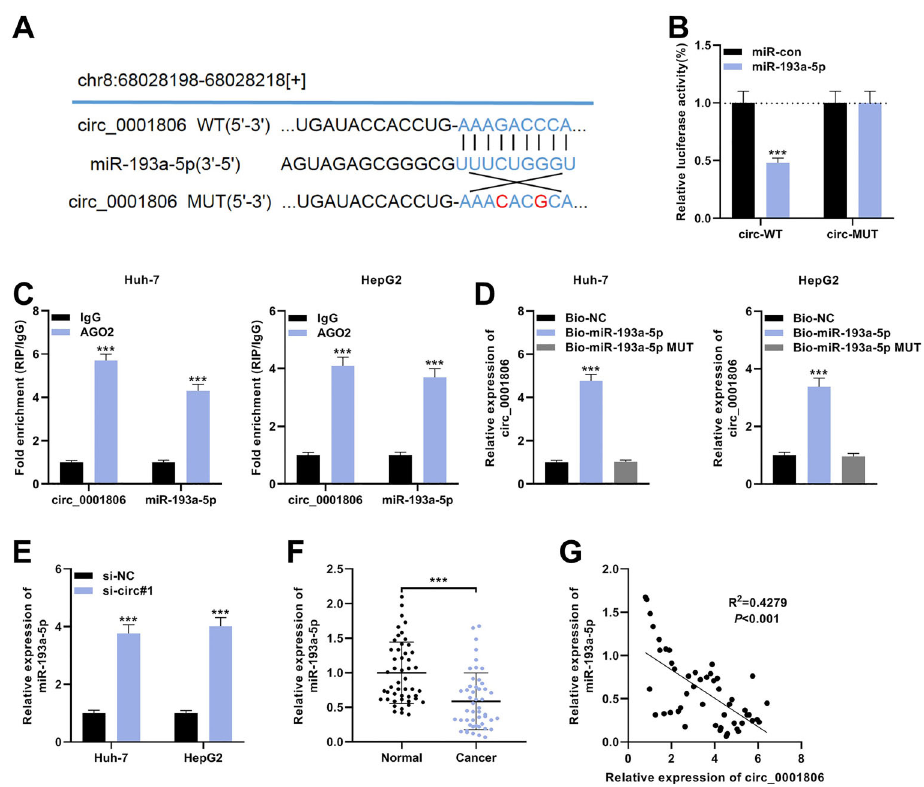
Figure 3. miR-193a-5p is the downstream target of circ_0001806. A , Bioinformatics analysis predicted that the sequence of miR-193a- 5p matched the sequences of circ_0001806, and circ_0001806-WT (wild-type) and circ_0001806-MUT (mutant) luciferase reporter gene vectors were constructed. B , miR-193a-5p mimics (or miR control) were co-transfected with circ_0001806-WT (or circ_0001806- MUT) into HEK293T cells. After 48 h, the luciferase activity of the cells in each group was measured. C , The complex containing circ_0001806 and miR-193a-5p in Huh-7 and HepG2 cells was immunoprecipitated by anti-AGO2 using RIP assay. D , RNA pull-down assay was carried out to verify the interactions between circ_0001806 and miR-193a-5p. E , qRT-PCR was used to detect the expression of miR-193a-5p in Huh-7 and HepG2 cells after circ_0001806 knockdown. F , qRT-PCR was used to examine the expression levels of miR-193a-5p in 49 paired hepatocellular carcinoma (HCC) tissues and matched adjacent normal tissues. G , Pearson correlation analysis was utilized to evaluate the correlation between the expressions of circ_0001806 and miR-193a-5p in HCC tissues. Data are reported as means ± SD. ***P o 0.001 ( t